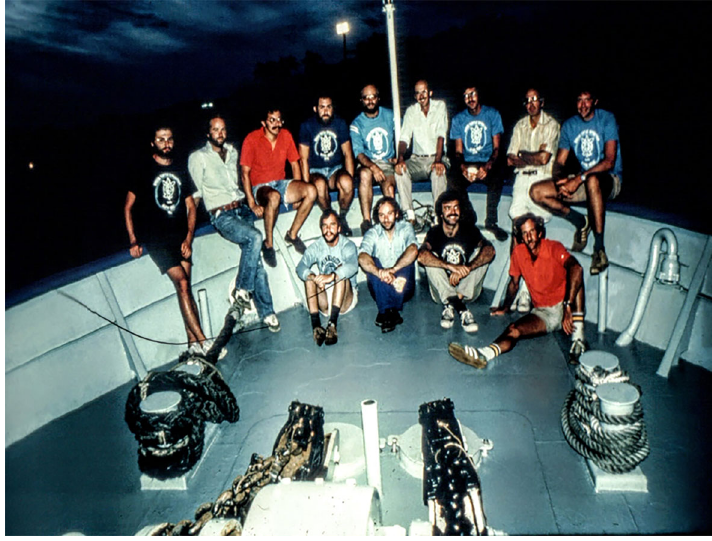
Figure 5. Mogens (front row center between Alan Hargens and Ron Millard) on the 1978 R/V Alpha Helix expedition to study green sea turtles in Puerto Limon, Costa